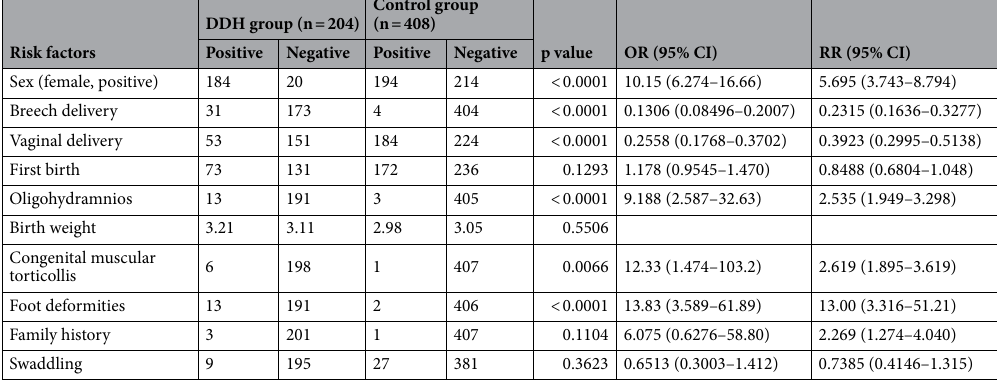
Table 1. Risk factors for the screening of developmental dysplasia of the hip. OR odds ratio, RR relative risk, CI confidence interval, DDH developmental dysplasia of the hip. p < 0.05 indicates a significant difference.